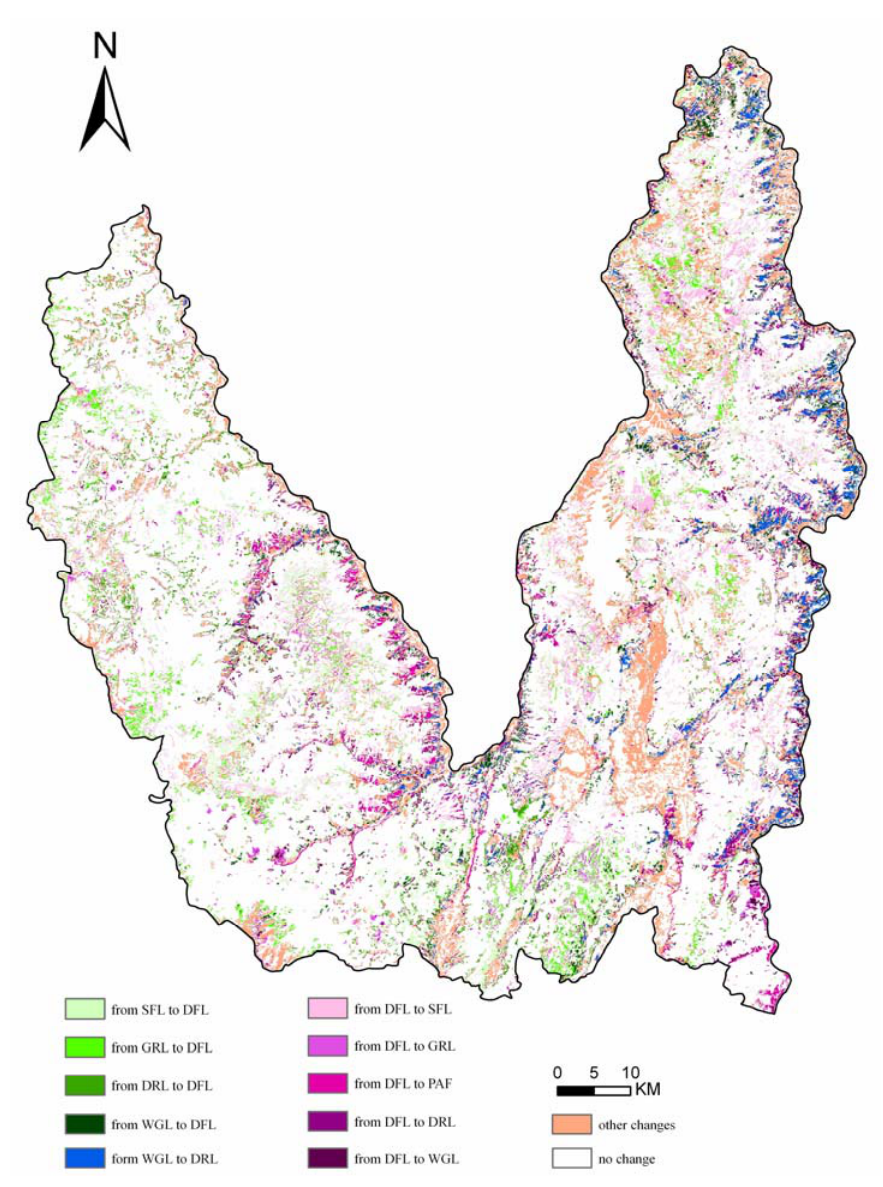
Figure 4. Dominant land use change processes in Lijiang County from 1986 to